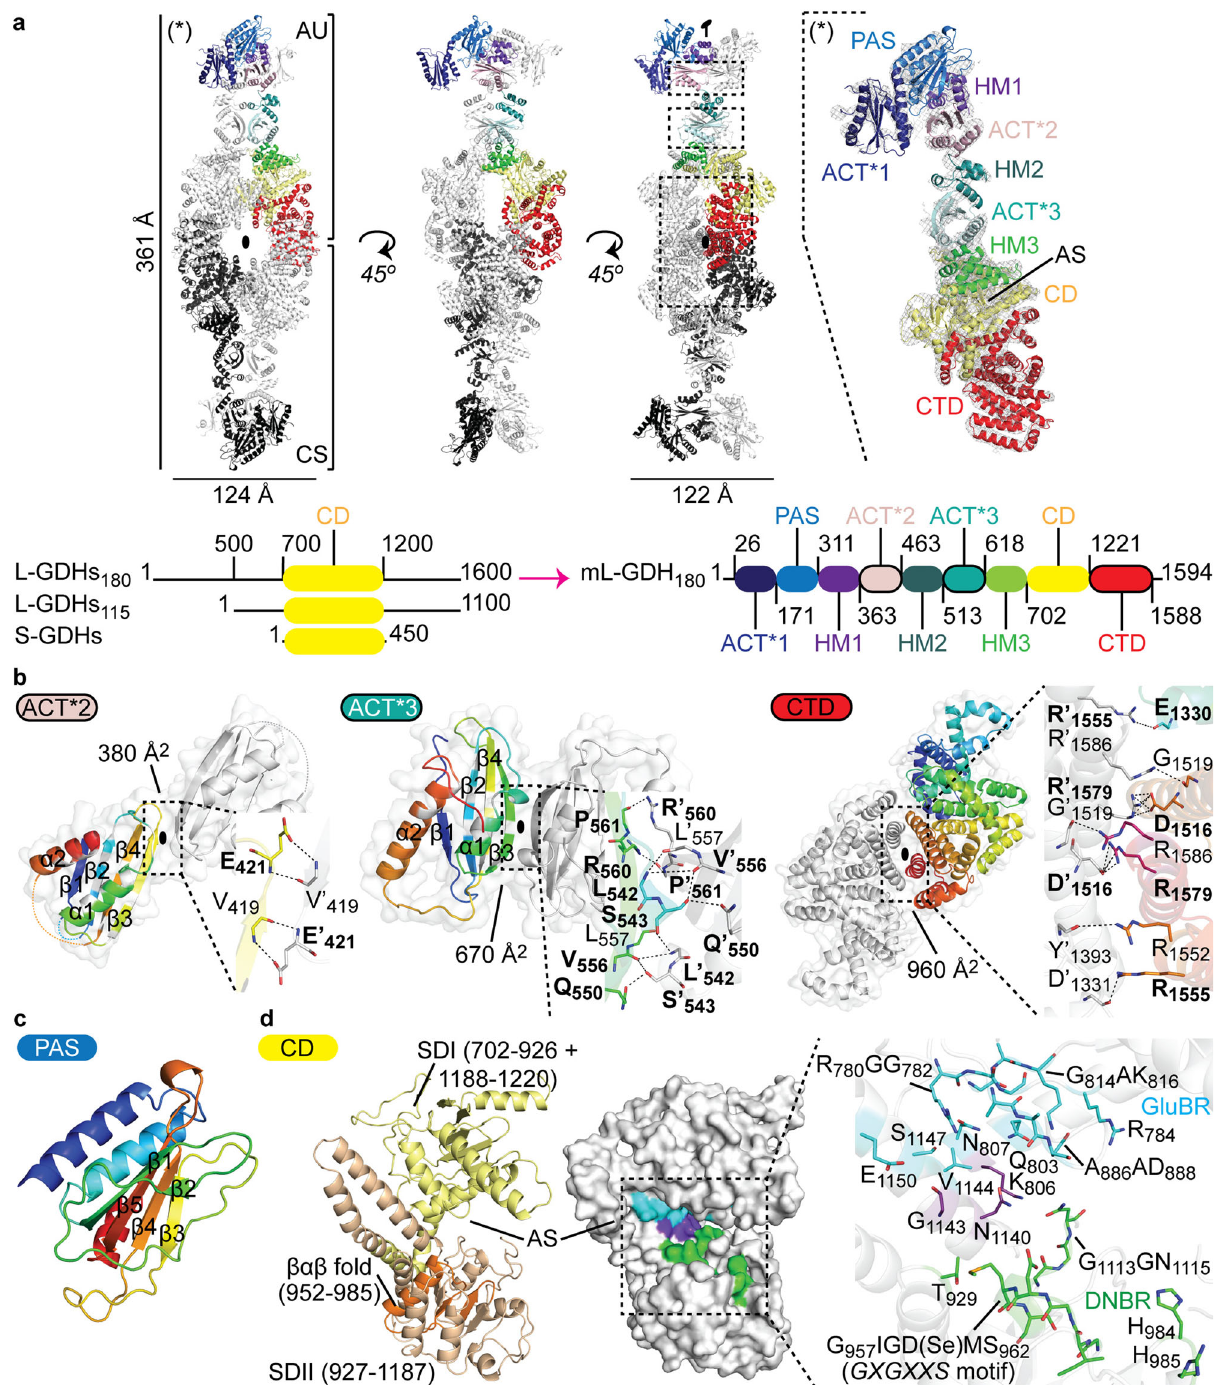
Fig. 1 Crystal structure of Se-Met mL-GDH180. a The asymmetric unit (AU) contains two monomers (RMSD of 0.51 Å for 289 alpha carbons in segment 45-362, 0.26Å for 1163 alpha carbons in segment 368-1588); a tetramer (as ribbons) is formed by crystallographic symmetry (CS); oval symbols represent twofold axes. The 2mFo – DFc electron density (gray mesh), contoured to 1.5 σ , is shown for one protein subunit on the right. Domains boundaries are given in residue numbers in a scheme below; CD catalytic domain, CTD C-terminal domain, AS active site. A comparative scheme of L-GDHs 180 , L-GDHs 115 , and S-GDHs 50 is also provided, with approximate residue numbers. b Oligomeric interfaces (areas in Å 2 ) involve the domains ACT*2, ACT*3, and CTD. Contacting residues (as sticks in insets) labeled in bold characters are strictly conserved in diverse L-GDHs. The topology of domains ACT*2 and ACT*3 is highlighted with rainbow colors; white positions within the rainbow depict conserved core residues 15 . c The PAS domain. d The CD is shown with the SDI and SDII in yellow and orange, respectively. The βαβ motif is involved in dinucleotide binding 1 . The glutamate-binding region (GluBR, cyan) and the dinucleotide-binding region (DNBR, green) 1 are highlighted in a surface representation and as sticks in an inset. Residues in purple conform both binding regions 1. See also Supplementary Figs. 1 and